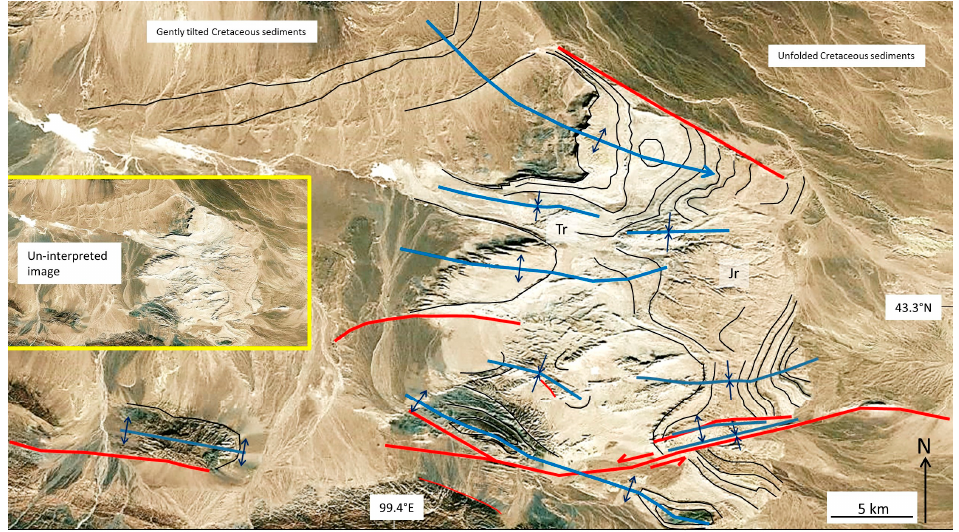
Figure 6. Google Earth (© 2016 DigitalGlobe) image interpretation showing bedding traces (dark blue lines), major fold hinges (light blue lines), and faults (red lines) in folded Triassic-Jurassic (Tr-Jr) succession, Ongon Ulaan, southwest Mongolia. Inset shows un-interpreted scene. See Figure 1 for